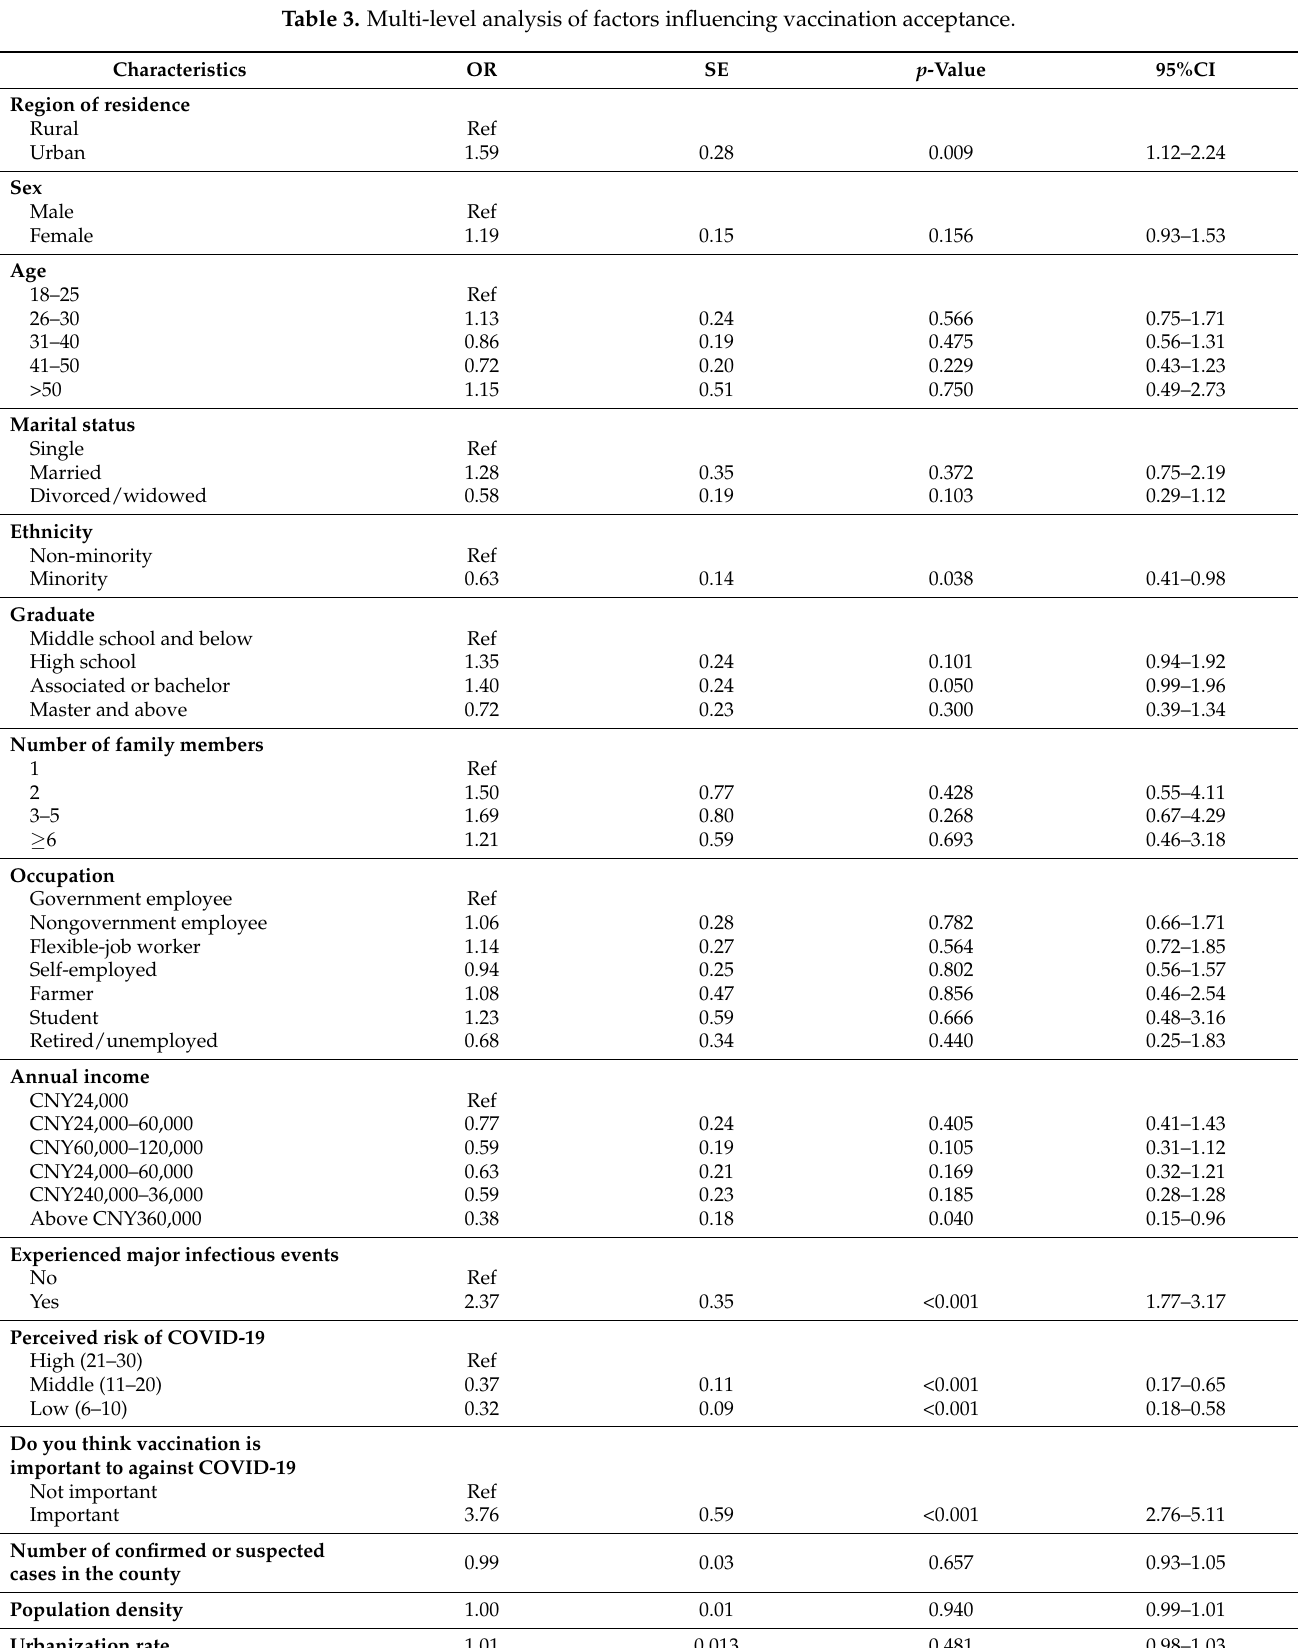
Table 3. Multi-level analysis of factors influencing vaccination